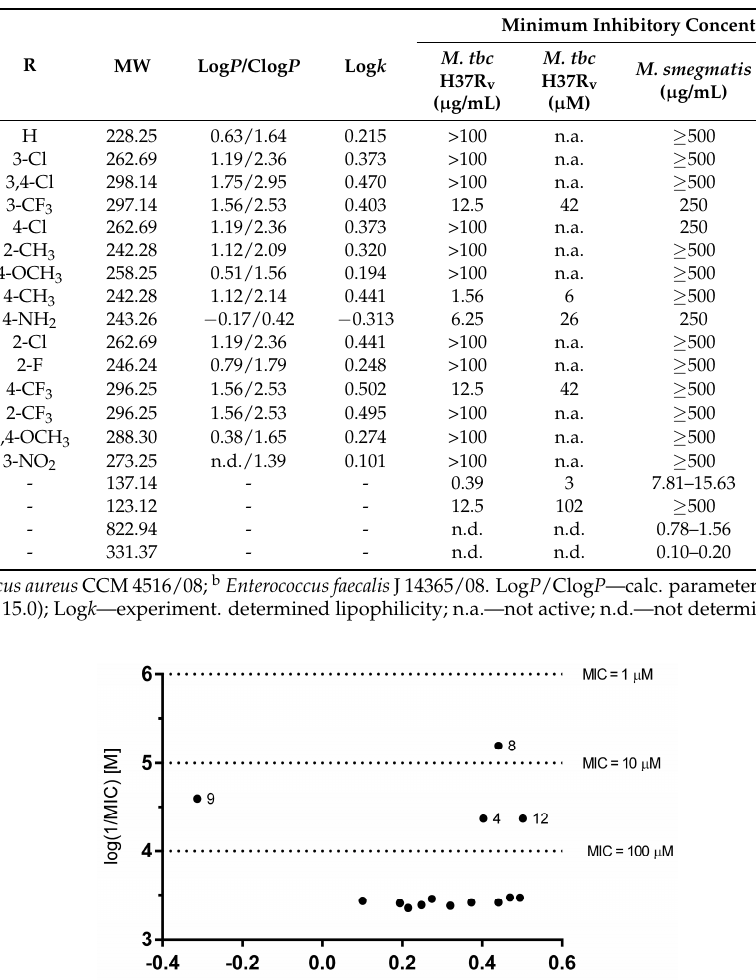
(Table 2, B) and 5-benzylamino-6-methylpyrazine-2,3-dicarbonitriles (Table 2, C) in order to compare the effect of cyano vs. carboxamide substitution. Table 2. Summary of prepared compounds, calculated and measured parameters of lipophilicity, results of antimycobacterial and antibacterial evaluation expressed as minimum inhibitory concentration (MIC) compared to standards.